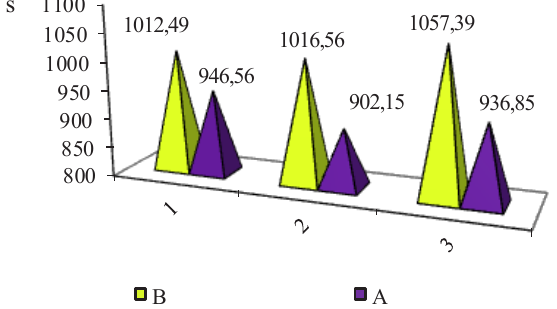
Fig. 2. Indicators of the endurance development level of girl-students of the experimental groups before and after the experiment. s – seconds; B – before the experiment; A – after the experiment; 1, 2, 3 – numbers of